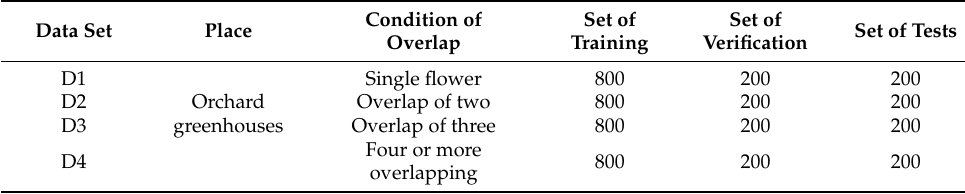
Figure 11. Images after data enhancement. Data sets D1, D2, D3, and D4 were constructed to compare the influence of data sets participating in the modelling of flower overlap recognition. For each overlap, 800 pieces were selected for model training, 200 pieces for model verification, and 200 pieces for model testing. The data set structure is shown in Table 1. Before the training procedure, the initial parameters of the YOLOv5 model were set (as shown in Table 2). Table 1. Data set structure.